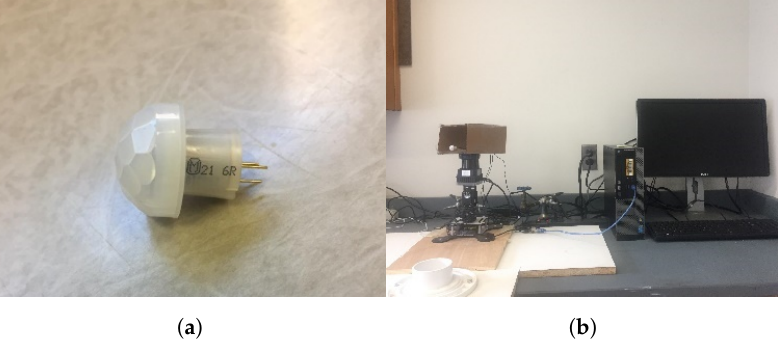
Figure 2. ( a ) The Panasonic AMN 24112 PIR sensor and ( b ) the complete MI-PIR